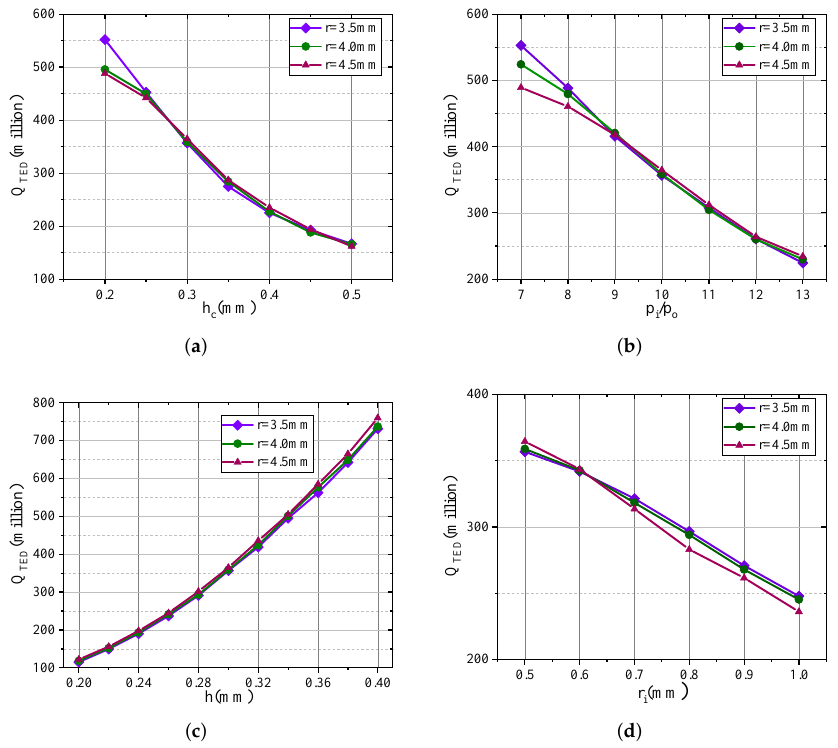
Figure 7. Q TED of microhemispherical shells with different parameters. ( a ) Influence of groove depth on Q TED . ( b ) Influence of pressure ratio inside and outside the groove on Q TED . ( c ) Influence of fused silica thickness on Q TED . ( d ) Influence of groove inner diameter on Q TED